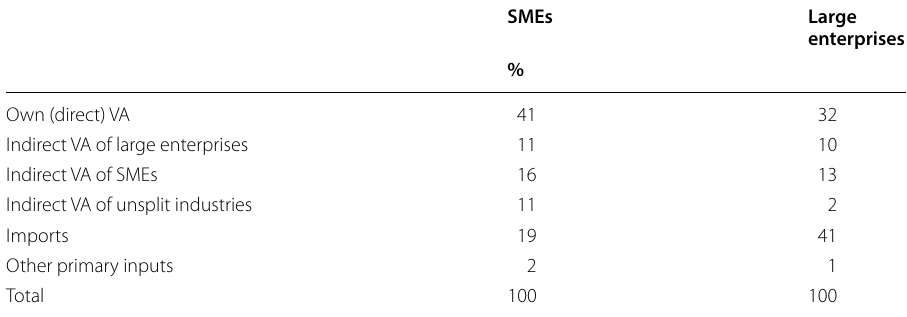
Table 3 Composition of the input used in final production, by size class, 2012